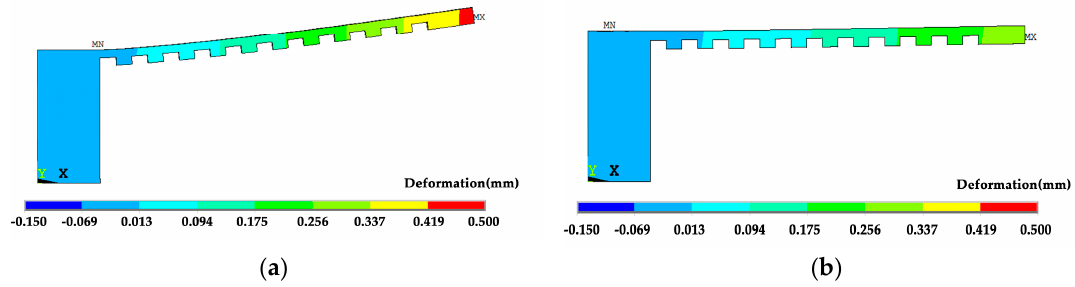
( b ) Figure 12. Shrinkage in the x direction of the specimens under different scanning strategies cooled to